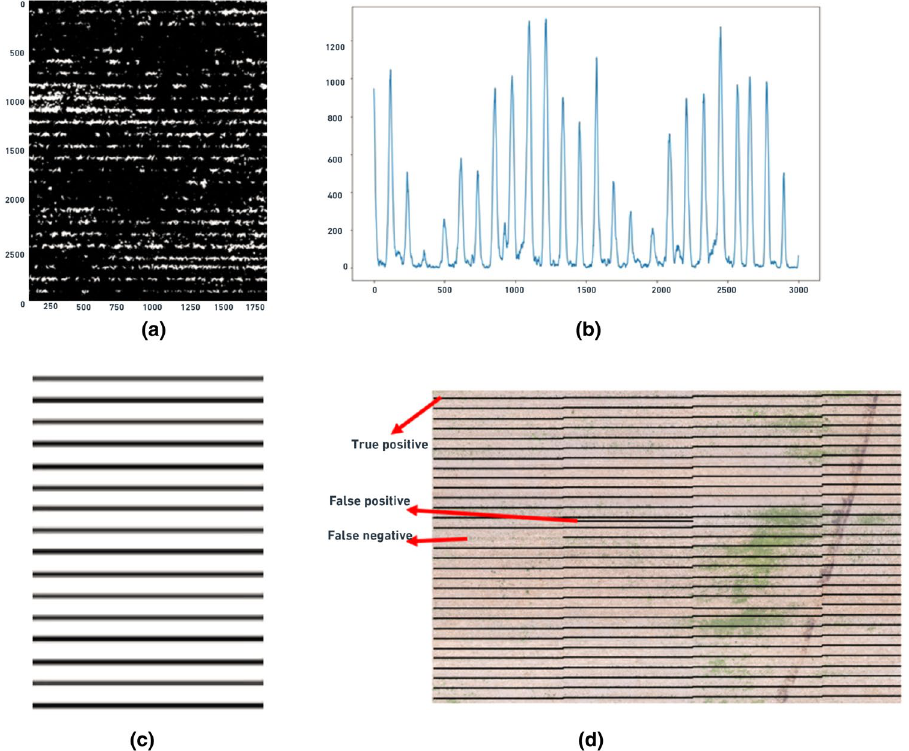
Figure 4. ( a ) A section of the binary ExGI imagery (3000 × 2000 pixels) showing the horizontal orientation of rows, ( b ) local maximums (or peaks) for each corn row on the section of imagery, ( c ) lines drawn over the each computed local maximum, and ( d ) Comparison of actual corn rows with the identified lines created by the CRI algorithm on a corn field